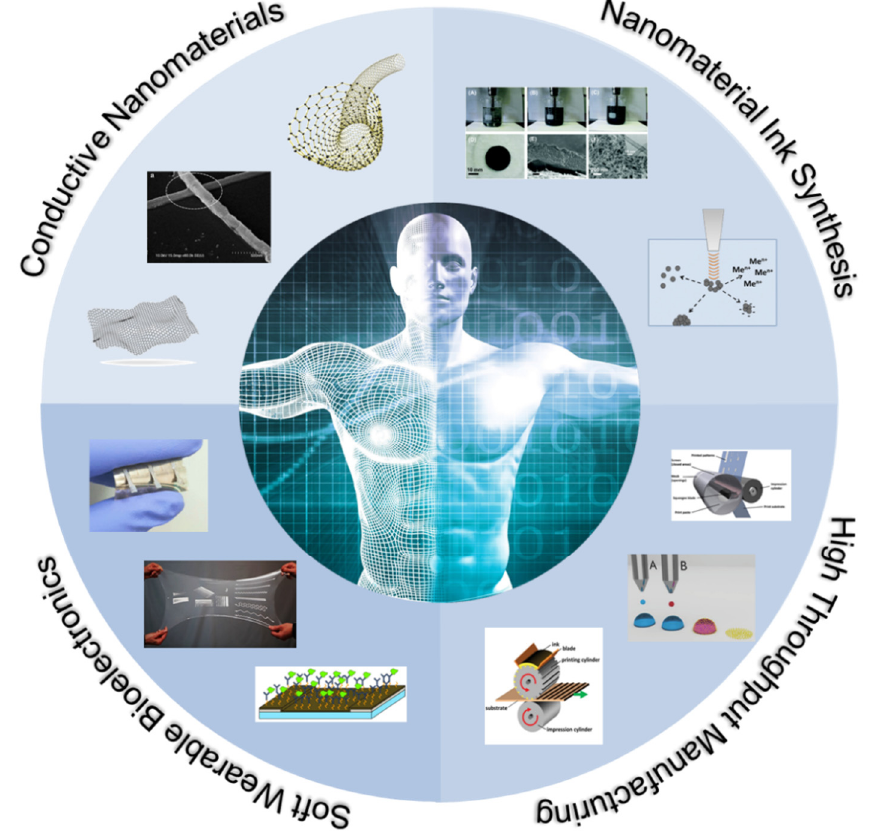
Figure 1. Overview of high-throughput nanomaterial fabrication methods and applications in soft bioelectronics. (Figures are adapted or reprinted, clockwise from the top: (1) RSC Adv. (2013), 3, 24812, Copyright 2013, RSC, (2) J. Nanoparticle Res. (2016), 18, 285, Copyright 2106, Springer, (3,7) Ind.